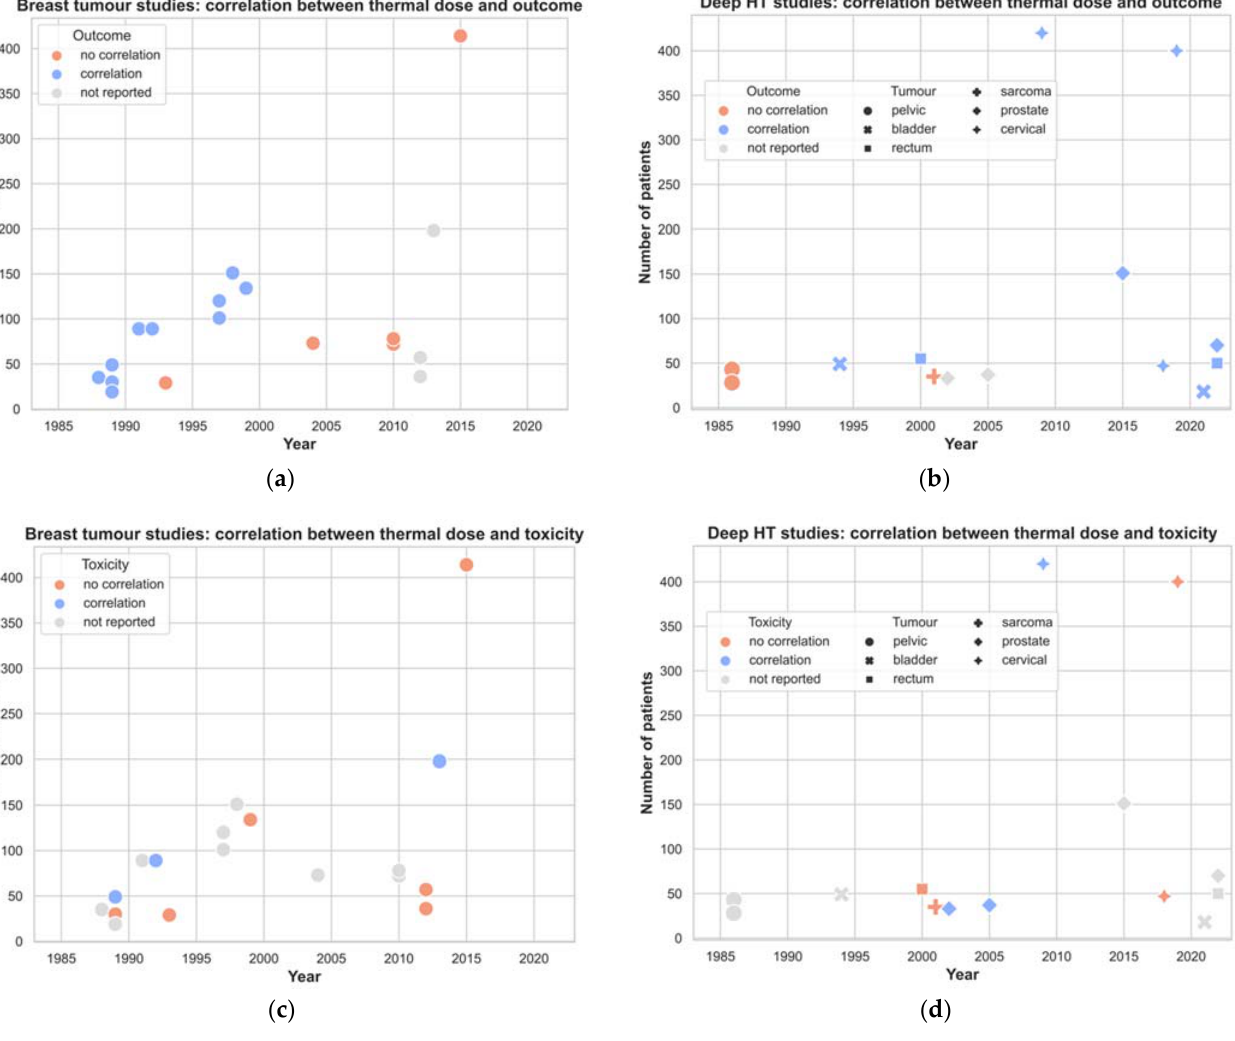
Figure 4. Overview of published studies on thermal dose effect relationships from 1985 to the present separated into superficial HT (breast tumours) and deep HT. Both treatment outcome and toxicity endpoints are shown: ( a ) reported association of thermal dose with outcome for superficial HT in breast tumours and ( b ) for deep HT; ( c ) reported association of thermal dose with toxicity for superficial HT toxicity in breast tumours and ( d ) deep HT.